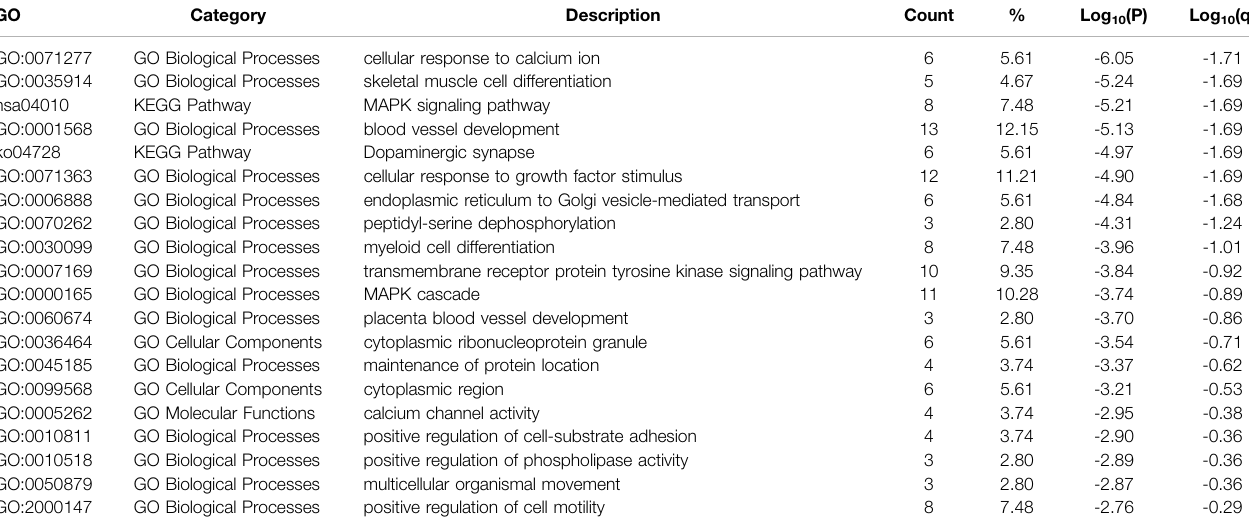
TABLE 4 | The GO and KEGG function enrichment analysis of genes related to 11-DMG mutation in GC.